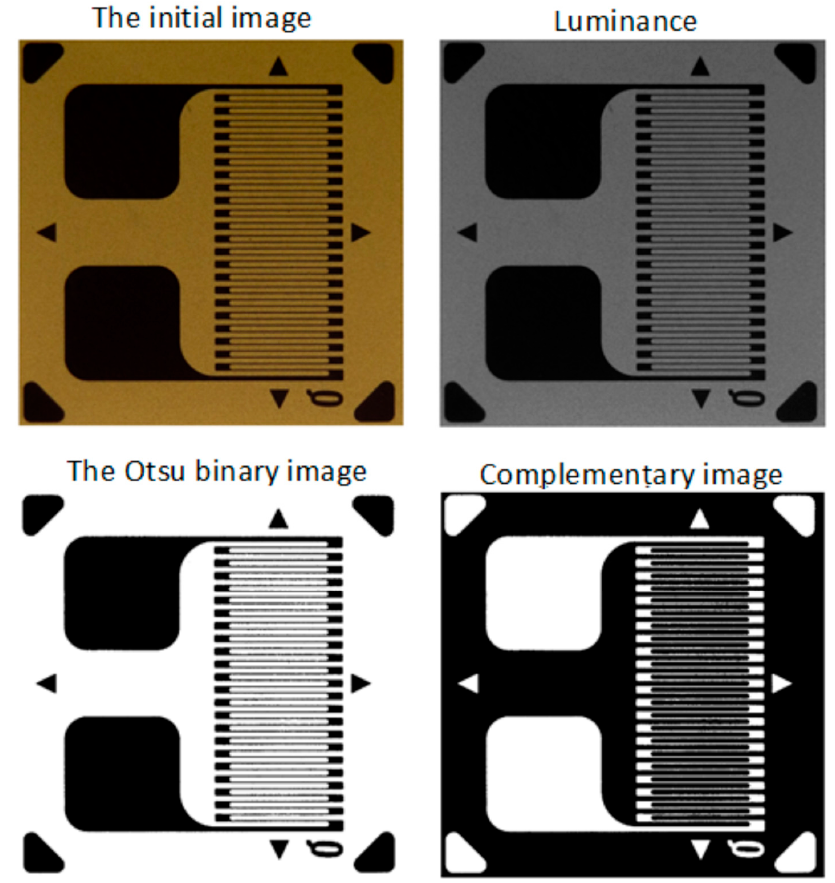
Figure 8. Obtaining the binary image for the type 1 transducer (step 3).